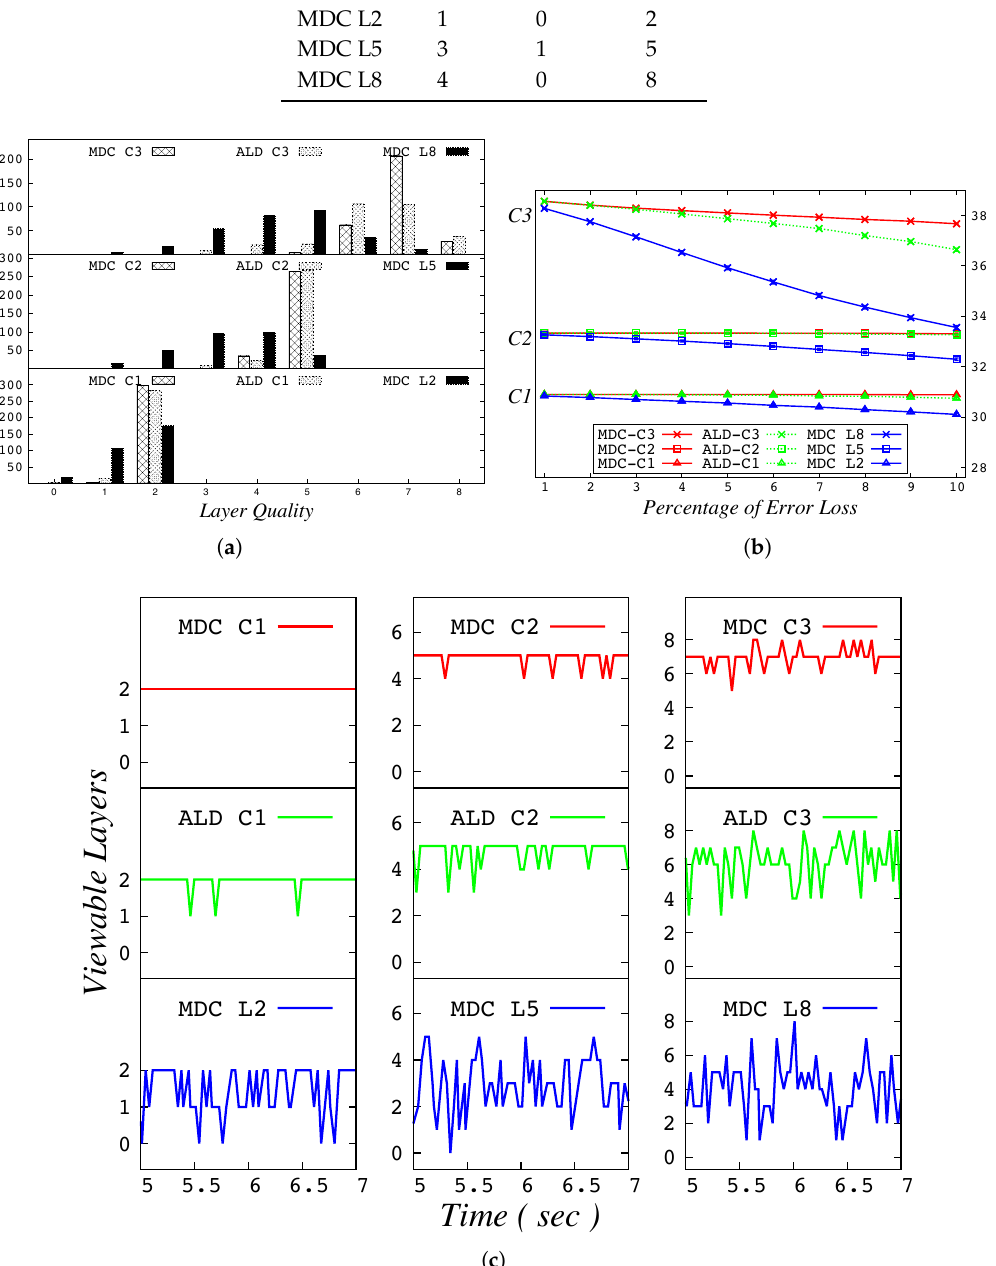
Figure 16. Performance evaluation of considered schemes using IRP for SCs. ( a ) video quality for different schemes at 10% loss; ( b ) average Y-PSNR values for different schemes with 95% confidence interval results; ( c ) 2 s sample of viewable quality